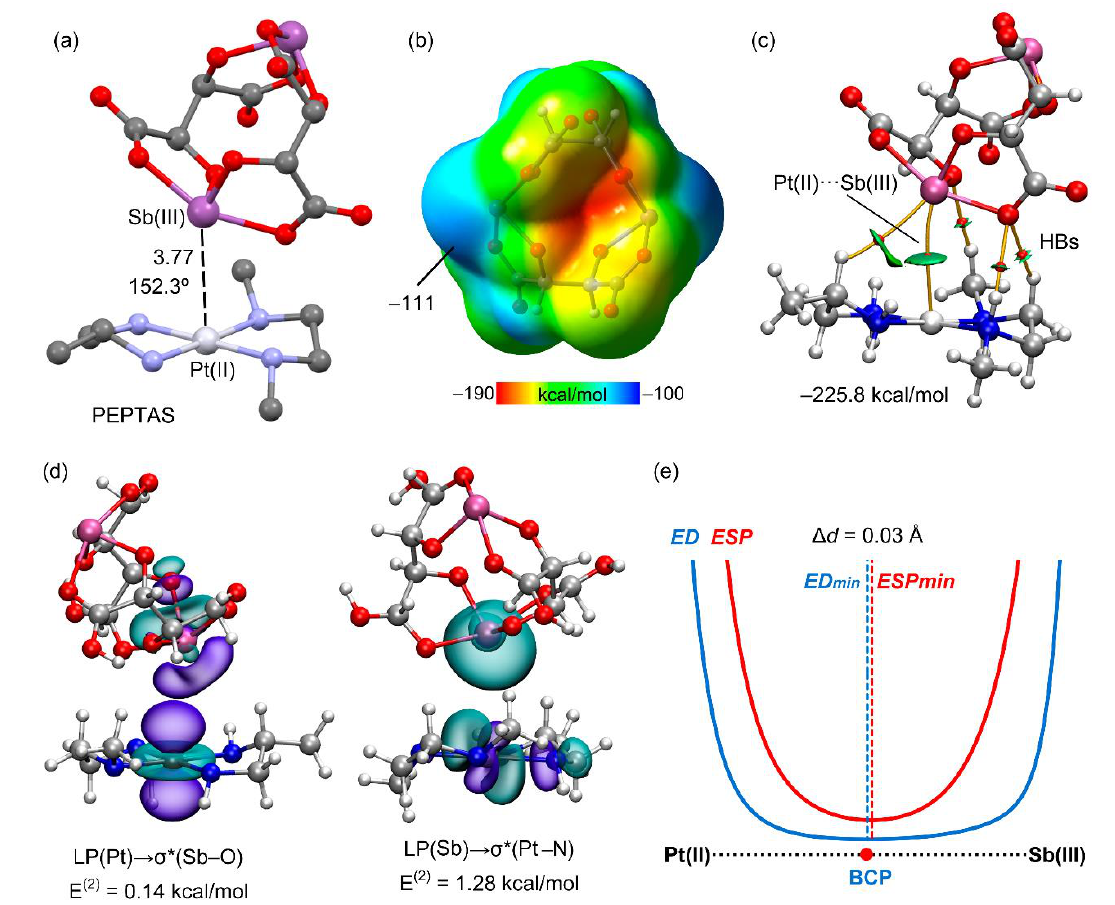
Figure 7. ( a ) X-ray structure of PEPTAS. Distances in Å. H-atoms omitted. ( b ) MEP surface of the [SbCl 5 ] 2 – unit. ( c ) QTAIM (bond CPs in red and bond paths as orange lines) and RDG isosurfaces of the salt. ( d ) NBO representations of the LP(Pt) → σ*(Sb– O) and LP(Sb) → σ*(Pt– N) interaction. ( e ) ED/ESP profile along the Pt(II)···Sb(III) bond path in PEPTAS.